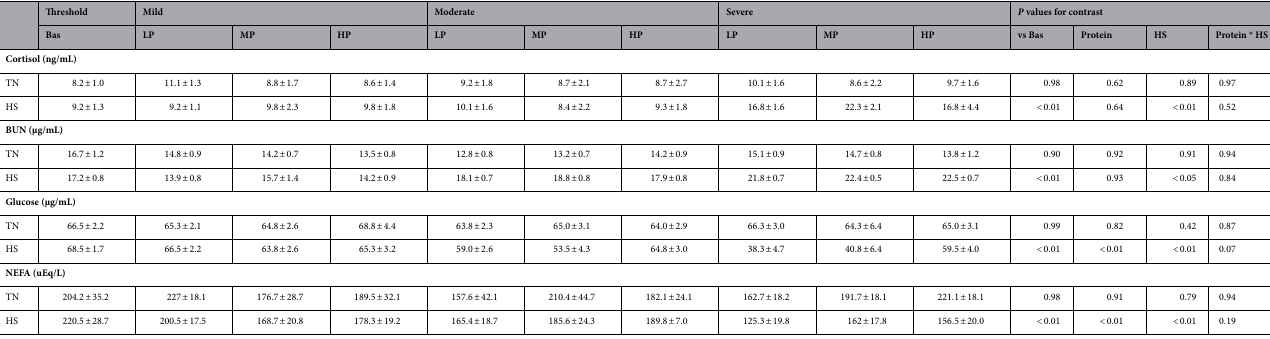
Table 7. Effects of dietary protein levels on blood parameters in Korean native beef calves under heat stress. vs Bas = Control (with 12.5% dietary protein levels, THI 68 to 70) vs 9 experimental diets (with 3 dietary protein levels, with 3 THI levels). THI = Temperature humidity index, THI = (1.8 × Tdb + 32) – [(0.55 – 0.0055 × RH) × (1.8 × Tdb − 26.8). Threshold = THI 70 to 73, Mild = THI 74 to 76, Moderate = THI 81 to 83, Severe = THI 89 to 91. LP = Low protein (12.5%), MP = Medium protein (15%), HP = High protein (17.5%). The data are presented as the means ± standards error (n = 4/group).